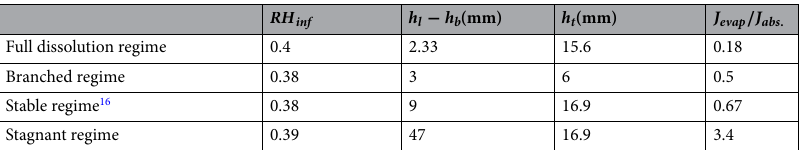
Table 1. Initial values of the relative humidity in the enclosure, distance h l − h b between the crust bottom surface and water table (Fig. 1), distance h t between the crust top surface and the cell top (Fig. 1), and evaporation rate-absorption rate ratio estimated from Fick’s laws assuming the crust pores occupied by a saturated NaCl aqueous solution for the four experiments considered in the